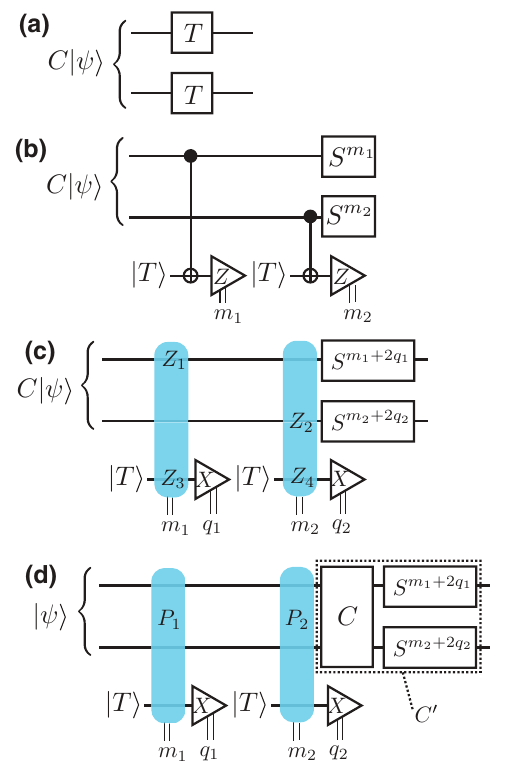
FIG. 1. Equivalent approaches to implementing two T gates. The blue rounded rectangles show multiqubit Pauli measure- ments. (a) A simple unitary circuit approach. (b) The use of √ 2 magic states, gate teleportation with | T (cid:3) : = ( | 0 (cid:3) + e i π/ 4 | 1 (cid:3) )/ controlled- NOT ( CNOT ) gates, Pauli Z measurements with out- comes m 1 and m 2 , and classical conditioned Cliffords based on these outcomes. The conditional S gates are S = | 0 (cid:3)(cid:5) 0 | + i | 1 (cid:3)(cid:5) 1 | . (c) The use of gate teleportation with the CNOT gates replaced by two-qubit Pauli measurements. (d) Given an input state | ψ (cid:3) that carries a Clifford frame correction C , we conjugate C through the circuit so that the multiqubit Pauli measurements are now P 1 = CZ 1 Z 3 C † and P 2 = CZ 2 Z 4 C † (which commute) and the output state carries a new Clifford frame correction + 2 q 1 + 2 q 2 S m 2 C . This last circuit represents the standard C (cid:6) = S m 1 1 2 PBC approach for computing T ⊗ 2